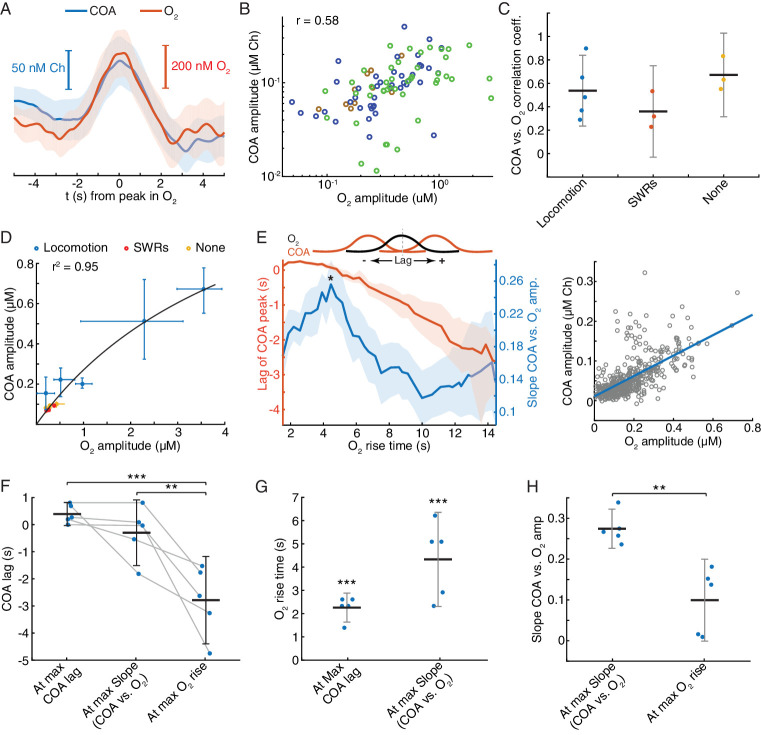
Correlation between COA and spontaneous O2 transients suggests O2-COA directionality.(A) Average COA and O2 dynamics triggered to fast O2 transients (duration ~5 s) detected outside periods when SWRs or locomotion bouts occurred. Data is from one recording session (n = 42 events). (B) Relationship between amplitudes of O2 and associated COA transients outside SWRs/locomotion bouts. Colors represent different recording sessions (n = 10–45 from three recordings, rspearman = 0.58, p<0.0001). (C) Group summary of COA vs. O2 amplitude correlations under different behavioral and/or electrophysiological contexts. (D) COA vs. O2 amplitude across animals and states. Each point represents the median of events from a recording session (error bars are CIs). Data were fitted to the Michaelis-Menten equation (Vmax = 1.58, Km = 4.84). (E) Lag of COA peaks relative to O2 peaks (red) and slope of COA vs. O2 amplitude (blue) for O2 transients with varying rise time for a single session; medians with CIs (left). Right shows the relationship between amplitudes of O2 and associated COA transients for the O2 rise time corresponding to largest slope marked with * on the left panel. (F) Group statistics on maximal COA lags, lags at maximal COA/O2 slope and lags associated with longest O2 transients (ANOVA, F2,12 = 15.22, with post-hoc Tukey test, p=0.51 for max COA lag vs. lag at max COA/O2, p=0.0006 for max COA lag vs. lag at max O2 rise and p=0.0038 for lag at maximal COA/O2 slope vs. lag at max O2 rise). (G) Group statistics on O2 rise times corresponding to maximal COA lags and COA/O2 slope in (E). Values from both groups were significantly lower than the longest O2 rise time observed in a given recording (p<0.0001, one-sample t-test). (H) Group statistics on the slopes of COA vs. O2 amplitude at its maximum value and at maximum O2 rise. Differences between groups were significant (p=0.002, paired t-test). ***p<0.001, **p<0.01. Data were obtained from five recording sessions in three mice and are represented as mean ± CI, except in D.